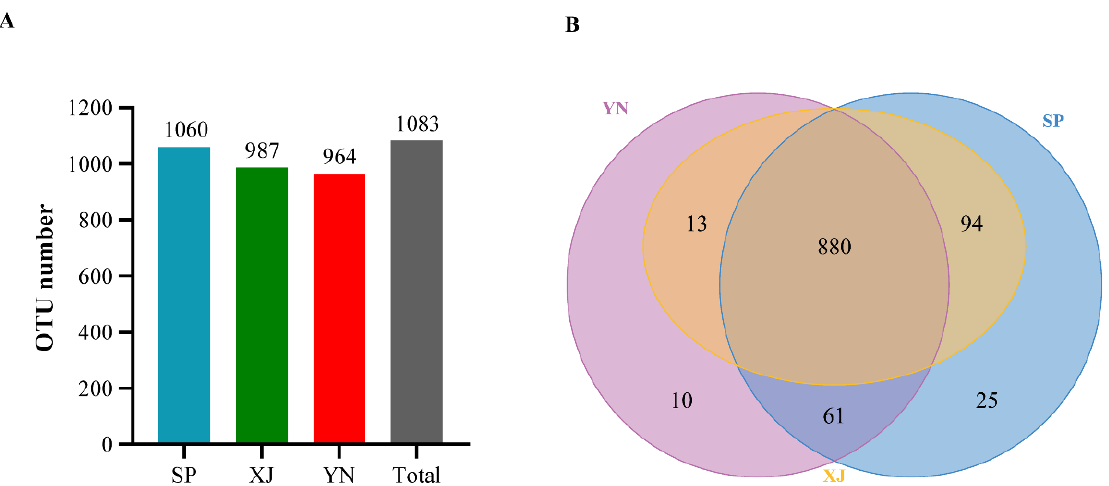
Figure 1. The results of OTU and Venn analyses of T. absoluta from different geographical populations. Abbreviations: SP, Spain; XJ, Xinjiang; YN, Yunnan. ( A ) Statistics on the OTU number in each sample. ( B ) Venn diagram of